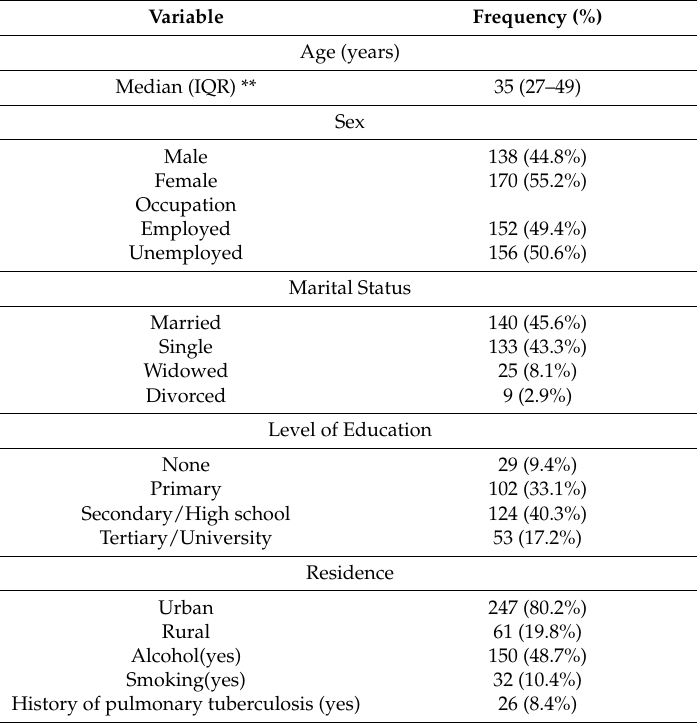
Table 1. Characteristics of the study